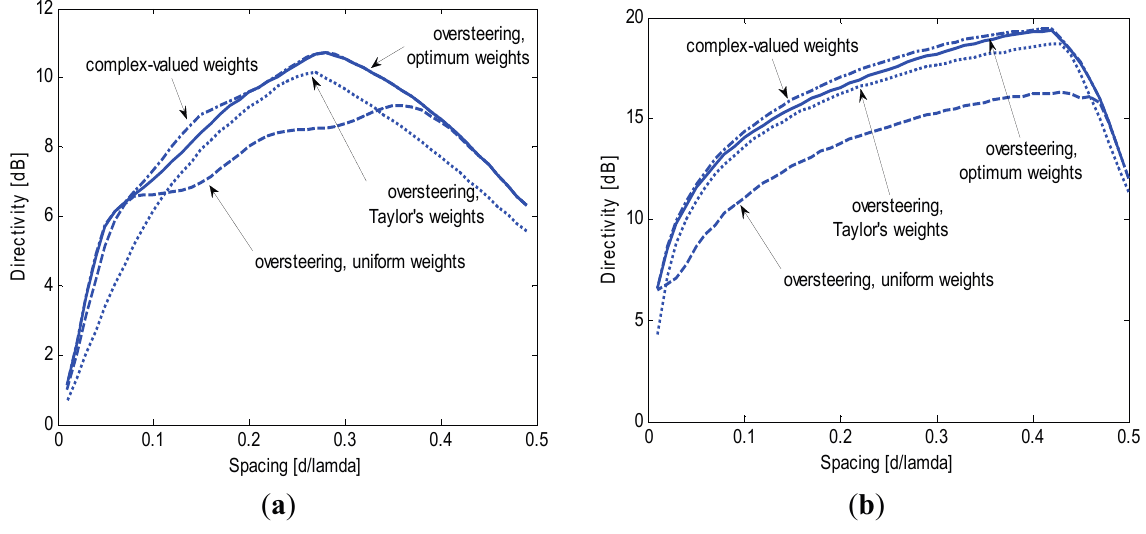
Figure 9. Maximum constrained directivity obtained for end-fire arrays of ( a ) N = 4 and ( b ) N = 16 sensors by imposing WNG ≥ 0 dB for the oversteering technique with optimum weights (solid line), uniform weights (dashed line), and Taylor’s weights (dotted line); the performance obtained without oversteering using optimum complex weights is included for comparison (dash-dotted